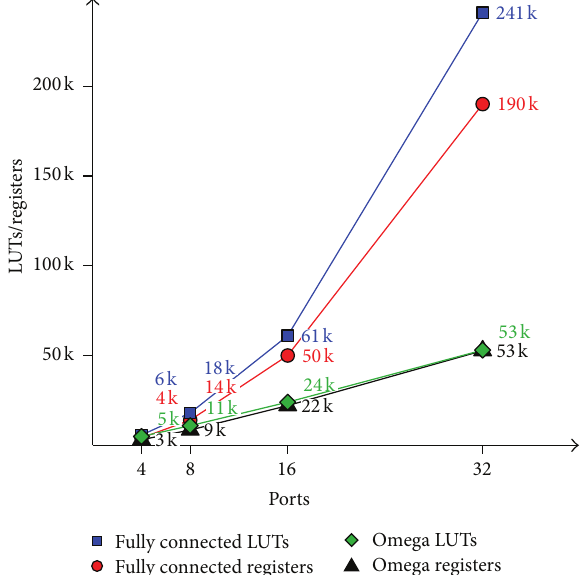
Figure 13: The effect of varying the number of ports on FPGA resource utilization (area) on the small resource memories. The fully connected memory grows by approximately 𝑁 2 and the Omega memory grows almost linearly.